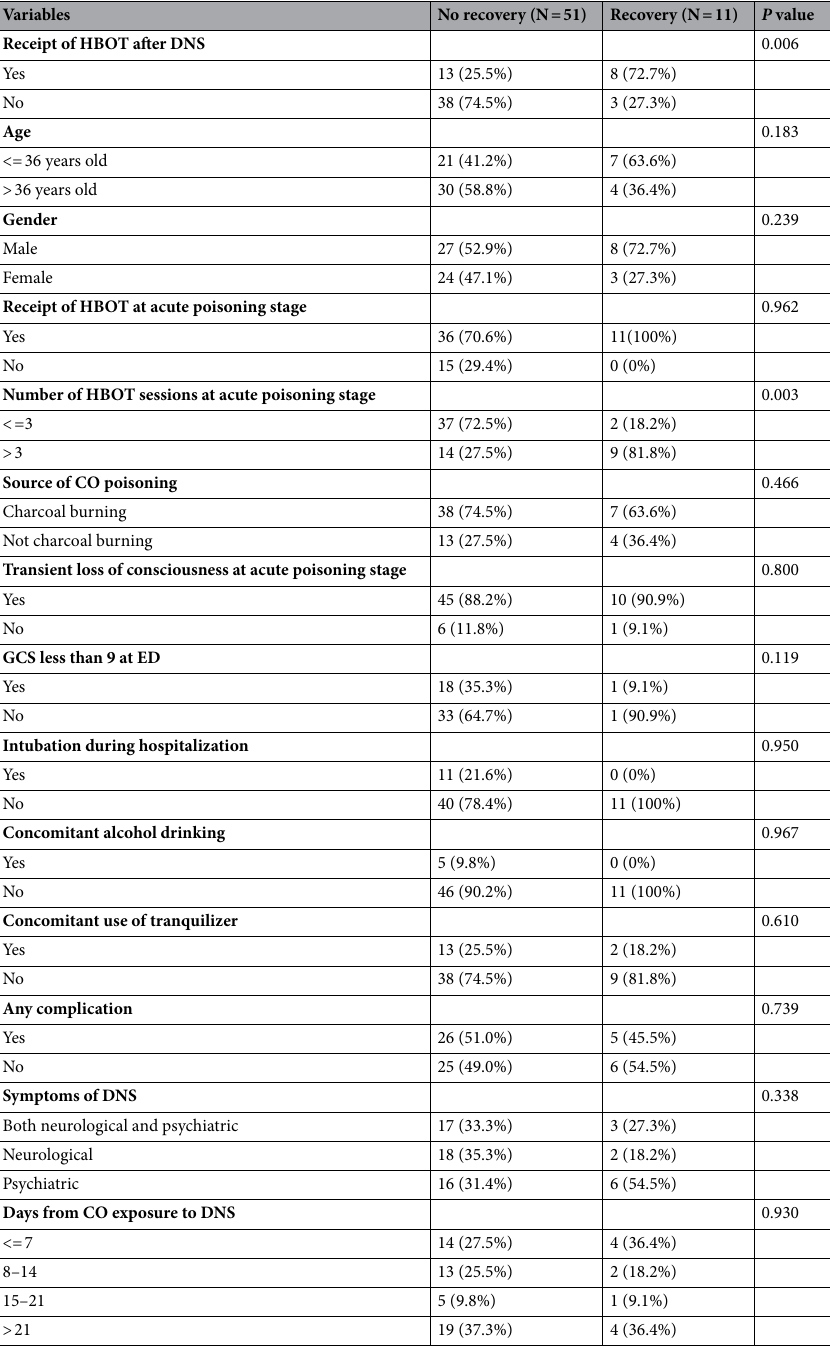
Table 2. Factors associated with the recovery from DNS. Continuous data are expressed as mean ± standard deviation; categorical data are presented as frequency (proportion). HBOT hyperbaric oxygen therapy, DNS delayed neuropsychiatric sequelae, GCS Glasgow Coma Scale, ED emergency